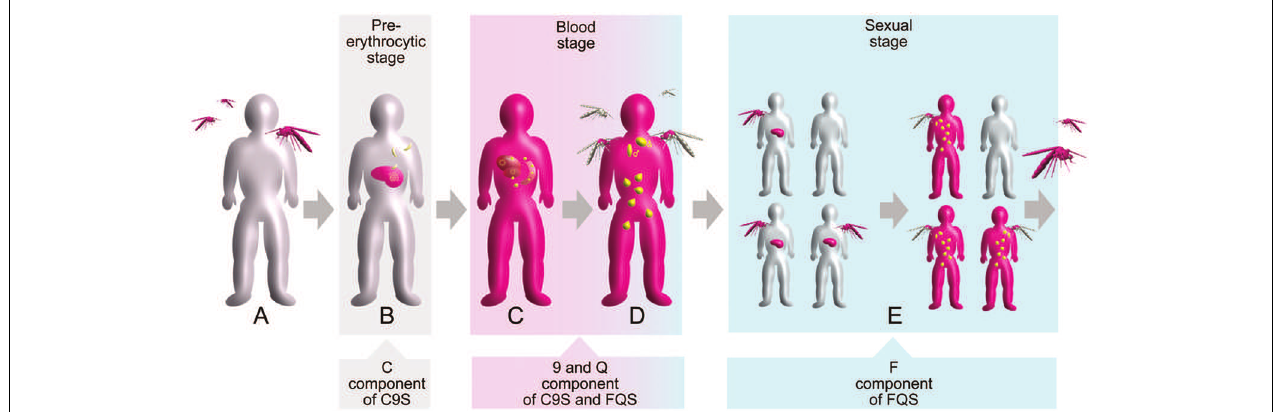
FIGURE 2 | Schematic overview of the Plasmodium falciparum life cycle in the context of human infection and transmission. The three main stages are indicated by colored boxes. Gray indicates healthy status whereas pink indicates infected status is. Different forms of the parasite are shown in yellow. Target points of the vaccine components are indicated by arrowed boxes. (A) Healthy individual. (B) Infection of liver cells after a mosquito bite. (C) Manifestation of blood-stage parasitemia. (D) Formation of gametocytes initiating the sexual stage. (E) Parasite transmission within a human community.